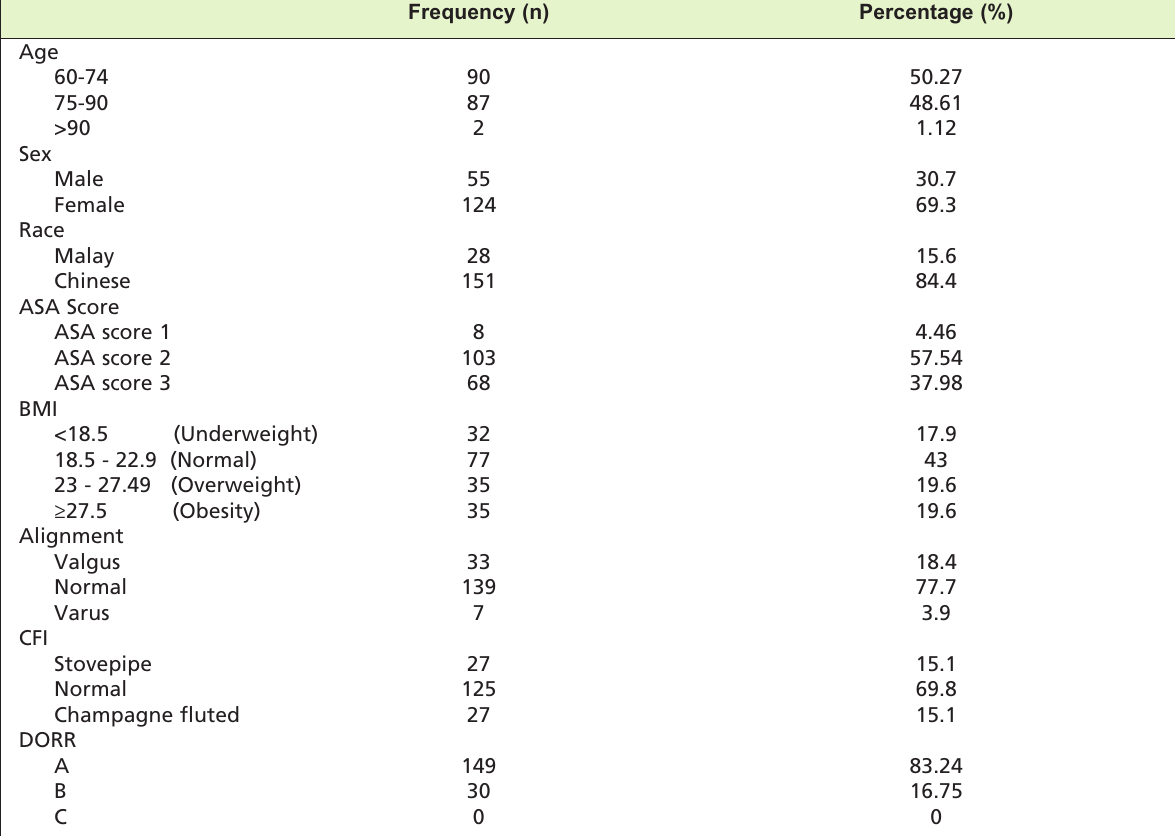
Demographics of Table I: